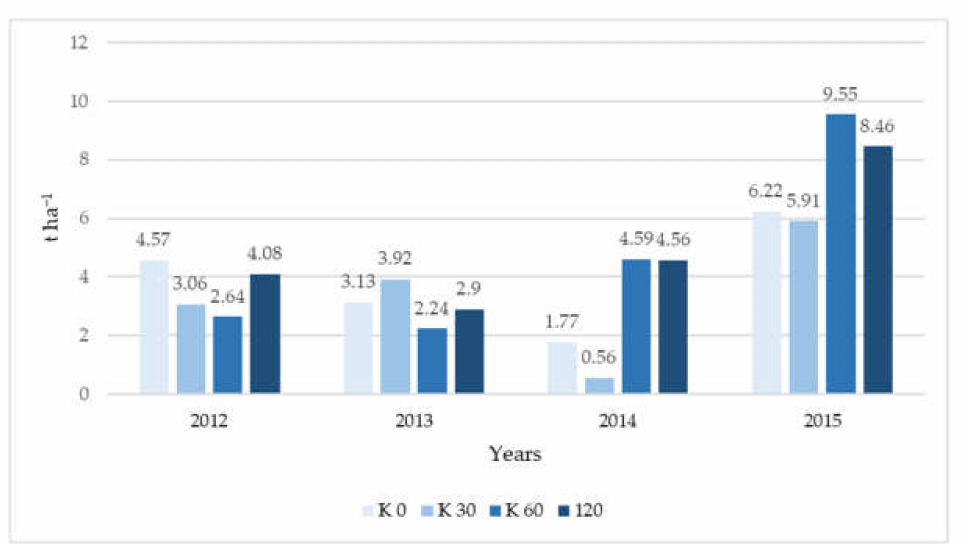
Figure 1. Increase sward yield in individual combinations of potassium fertilization under the influence of CaSO 4 (t ha − 1